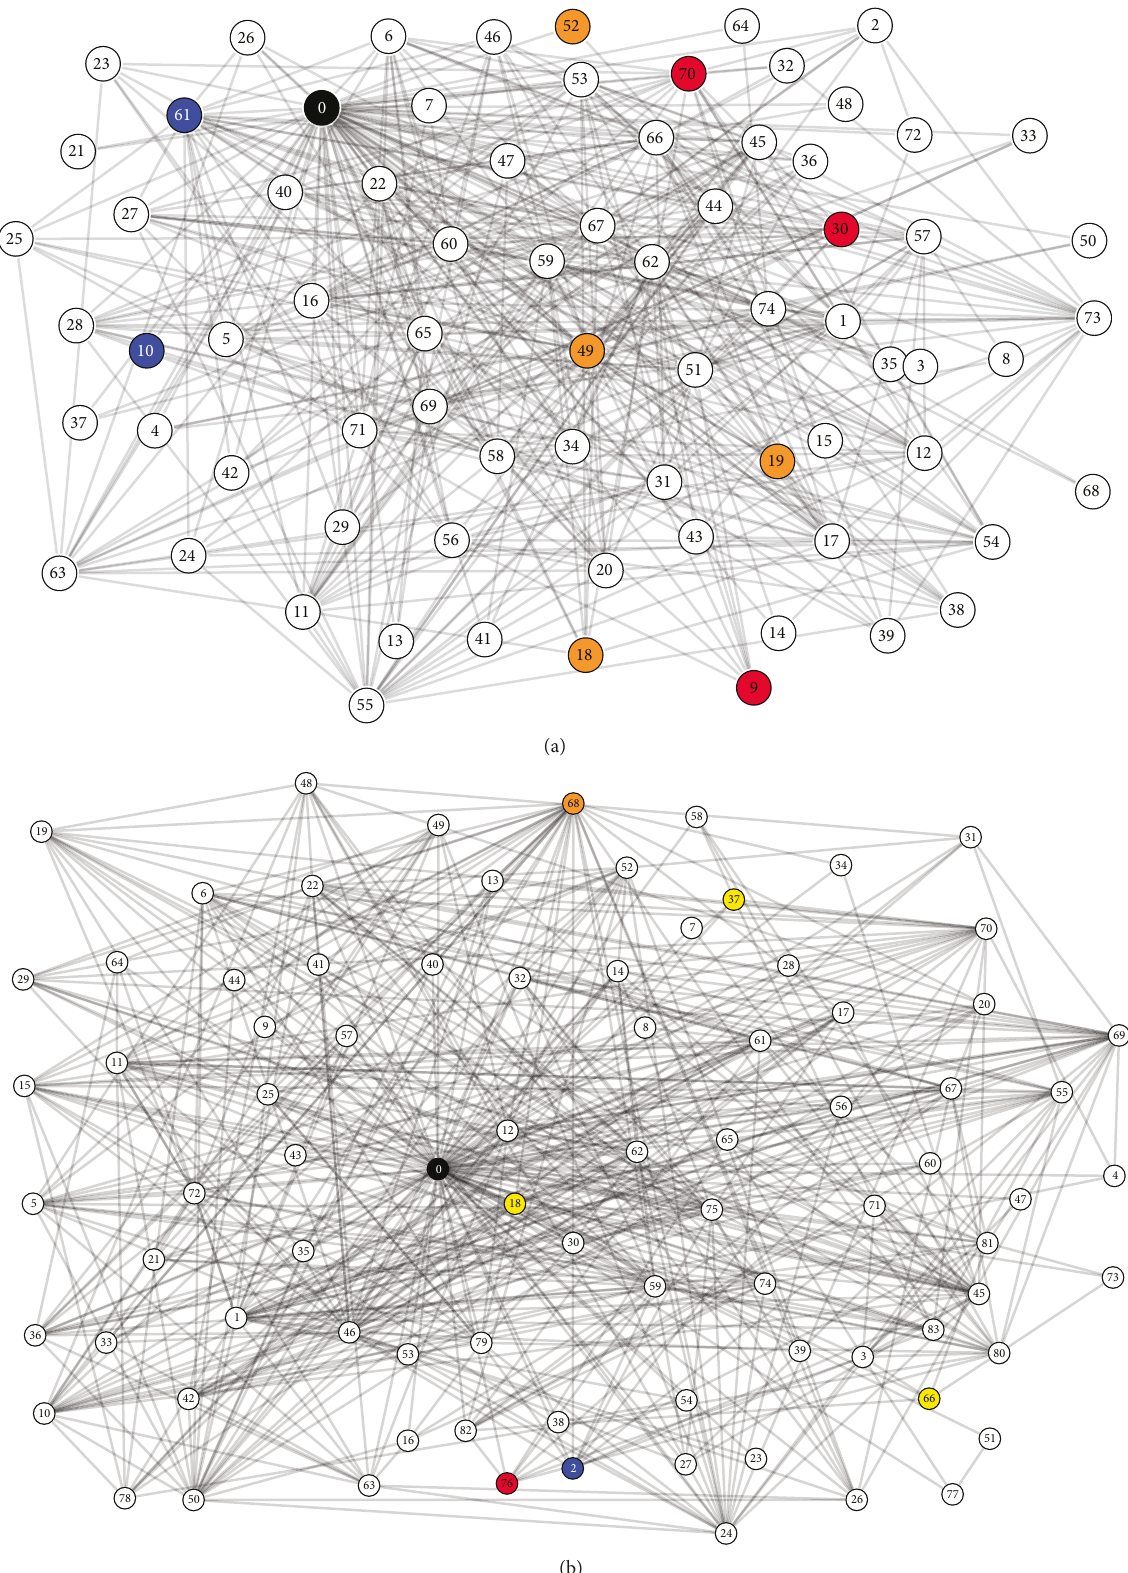
Figure 3: The food webs of the Sutton tussock grassland in spring (a; sutton sp ) and the Dempster tussock grassland in autumn (b; demp au ). The coloured species are explained in the